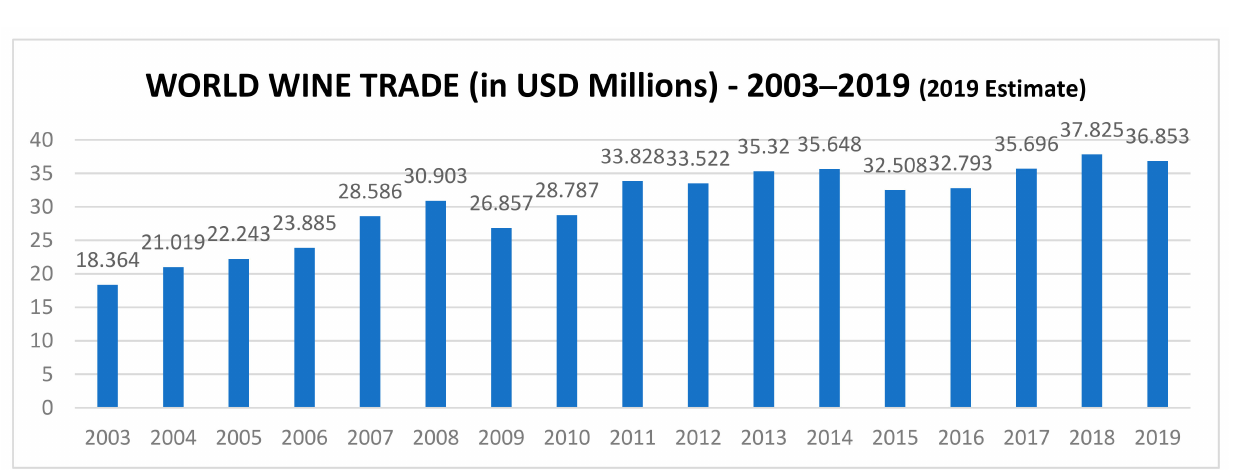
Figure 2. World wine trade 2003–*2019 (*Estimate). Source: The International Organization of Vine and Wine